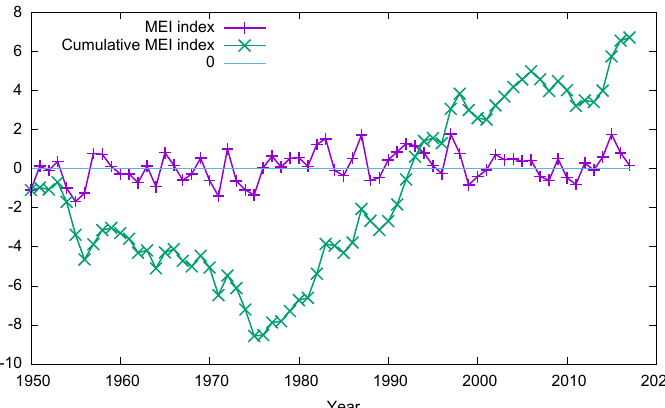
Figure 8. Purple: Multivariate El Niño Index (MEI); green: cumulative MEI